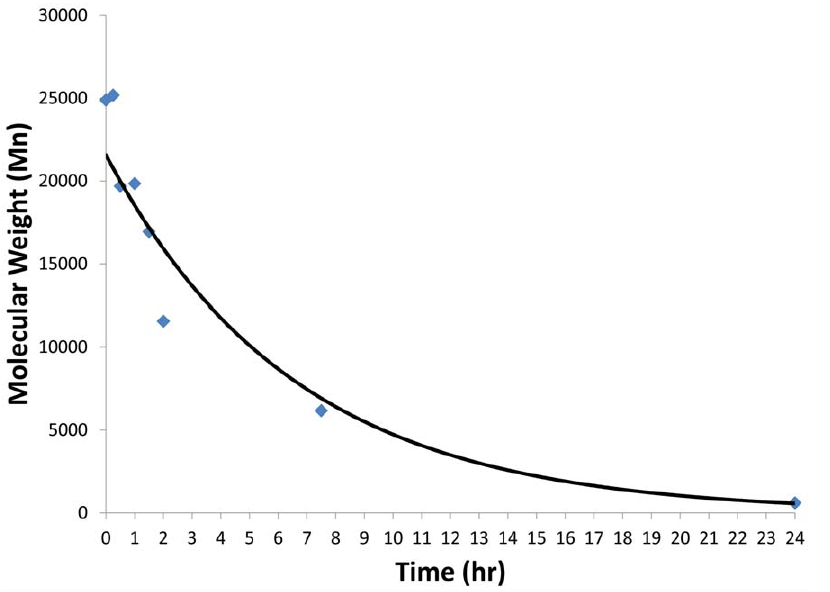
Figure 8. Number-averaged molecular weight versus time of B5-S5-E7 in PBS at 37 6 C with agitation. The half-life of the polymer in solution was 4.6 hr (R 2 =0.984), and the polymer was almost completely degraded within 1 day.